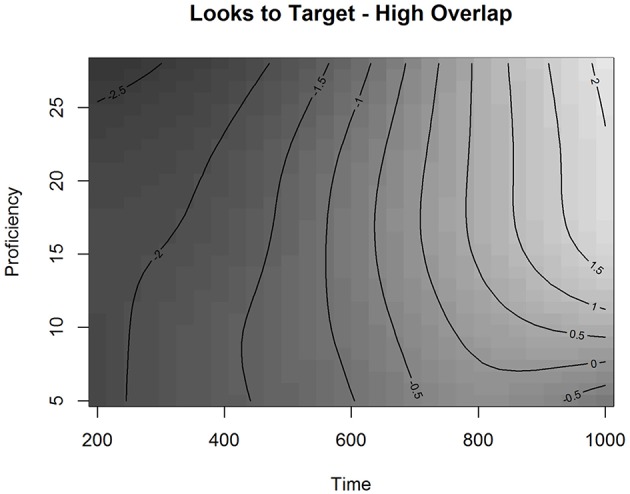
Partial effect of High orthographic Overlap as a function of Time and Proficiency in Experiment 2 in the L2 group.